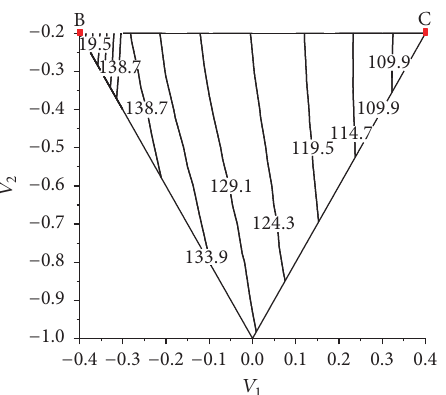
Figure 6: Flutter velocity contours for nonorthotropic sandwich panel with no gradient change ( 𝑉 3 = −0.6 , GF = 0).